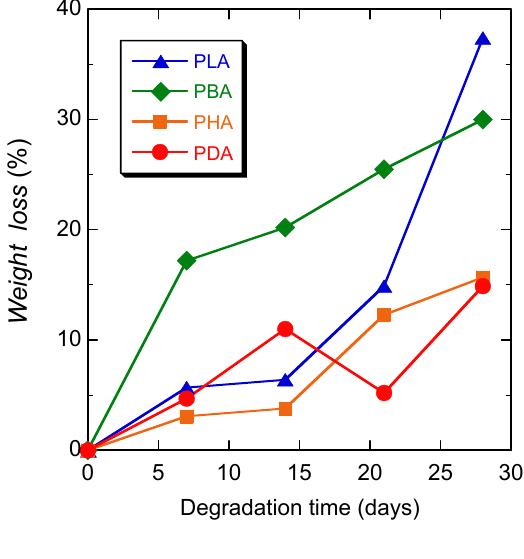
Figure 7. Weight loss of PLA, PBA, PHA, and PDA during hydrolytic degradation at 37 °C, as a function of degradation